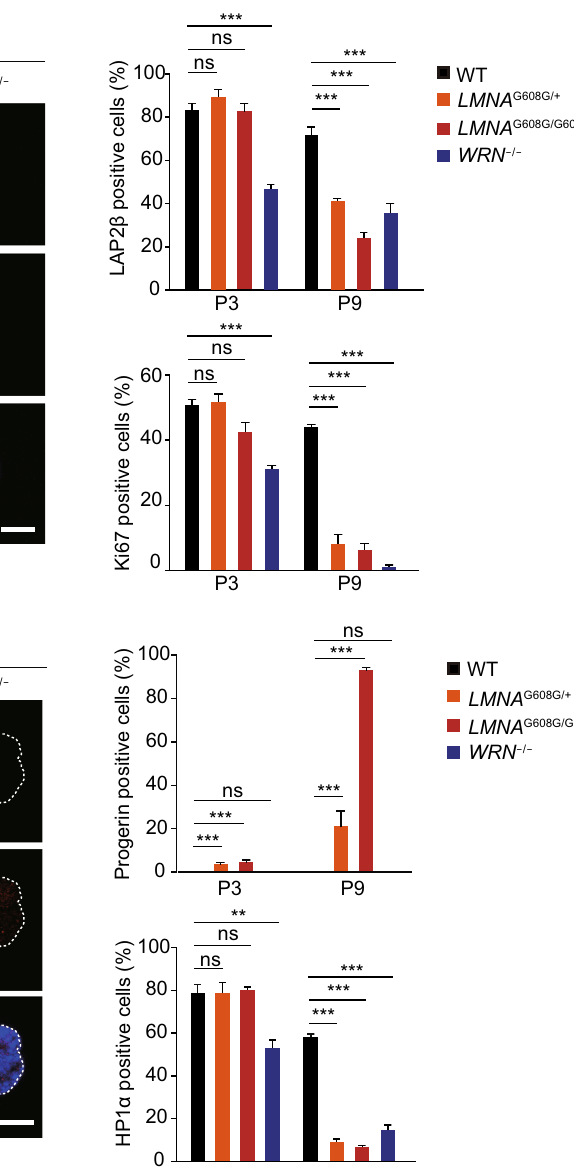
WRN in WS-ECs (Fig. 7D), HGPS-ECs and WS-ECs were still able to form lattice-like vessel structures on matrigel and maintain normal lipid uptake capacities, nitric oxide (NO)